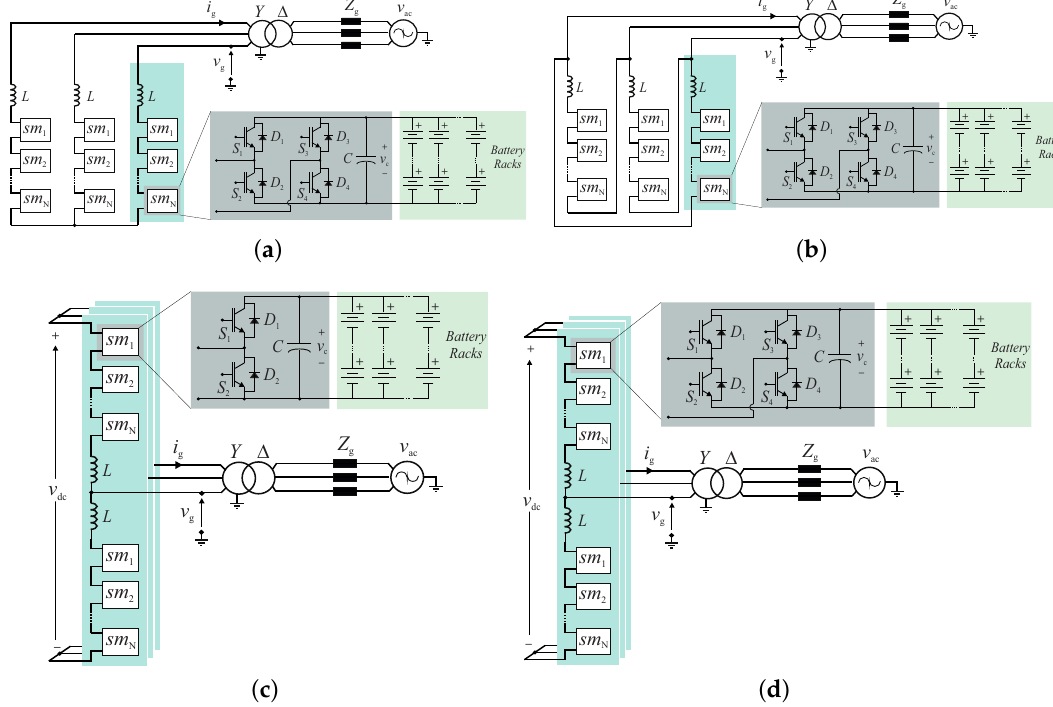
Figure 1. Possible realizations of the modular multilevel converter (MMC)-based energy storage static synchronous compensator (ES-STATCOM) with distributed energy storage: ( a ) Single-star bridge cell MMC with distributed energy storage (SSBC-DES). ( b ) Single-delta bridge cell MMC with distributed energy storage (SDBC-DES). ( c ) Double-star chopper cell MMC with distributed energy storage (DSCC-DES). ( d ) Double-star bridge cell MMC with distributed energy storage